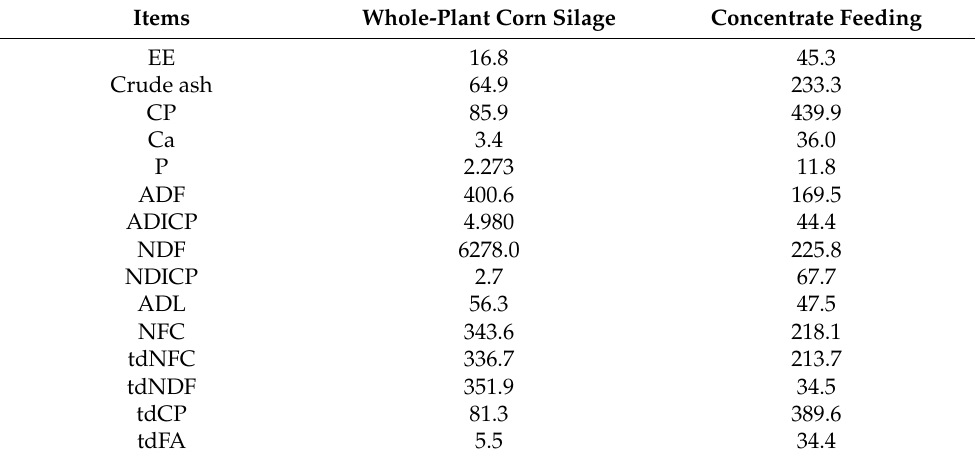
Abbreviations: EE ether extract, CP crude protein, Ca calcium, P phosphorus, ADF acid detergent fiber, ADICP acid detergent insoluble crude protein, NDF neutral detergent fiber, NDICP neutral detergent insoluble